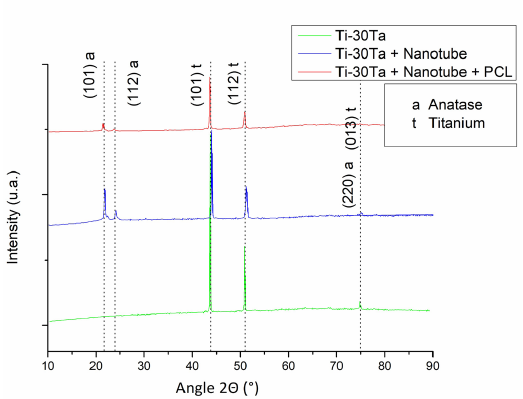
Figure 3. X-ray diffraction analysis (XRD) of Group 1 – Nanotubes of TiO , and Group 2 – Nanotubes of TiO 2